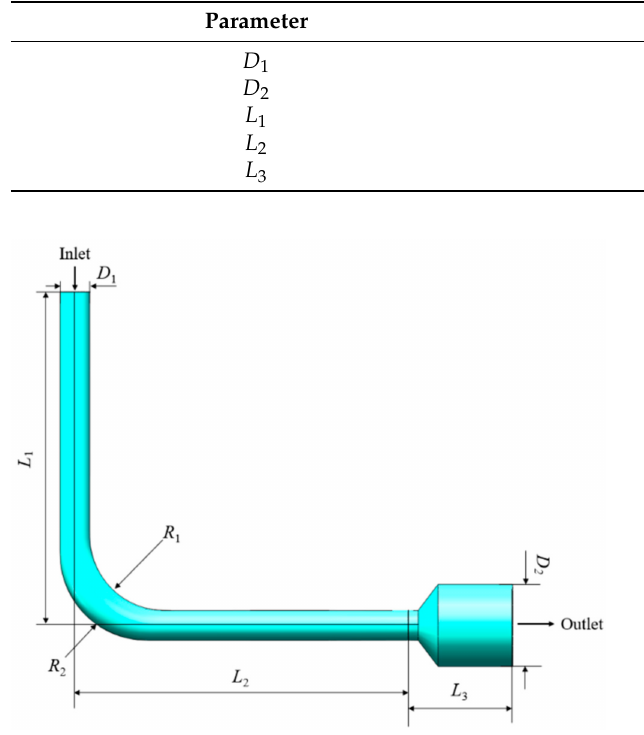
Figure 8. Fluid domain of the flow channel with design variables.